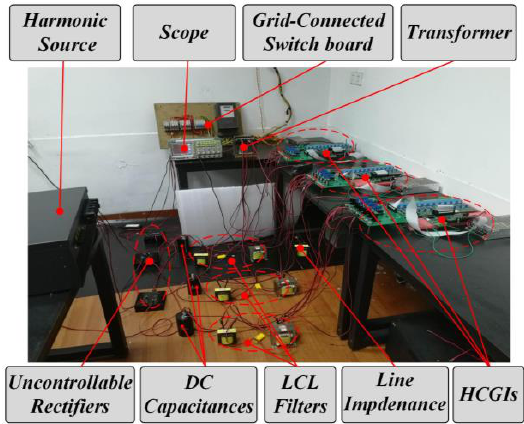
Figure 24. The experimental platform.